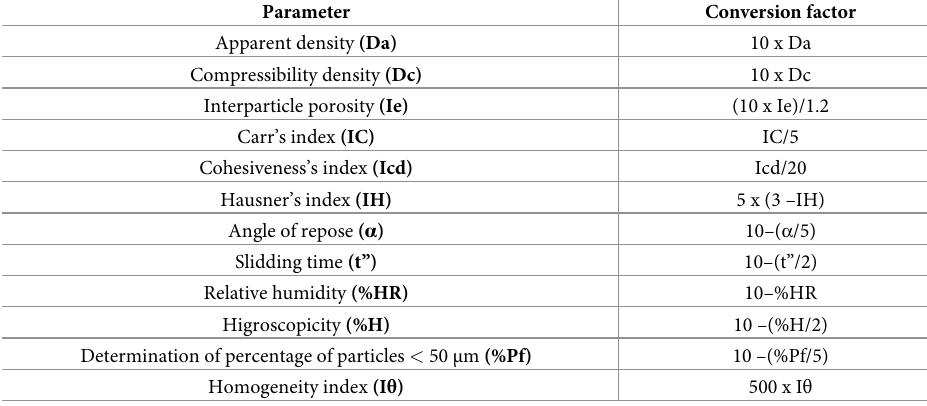
Table 1. Conversion factors to obtain “r